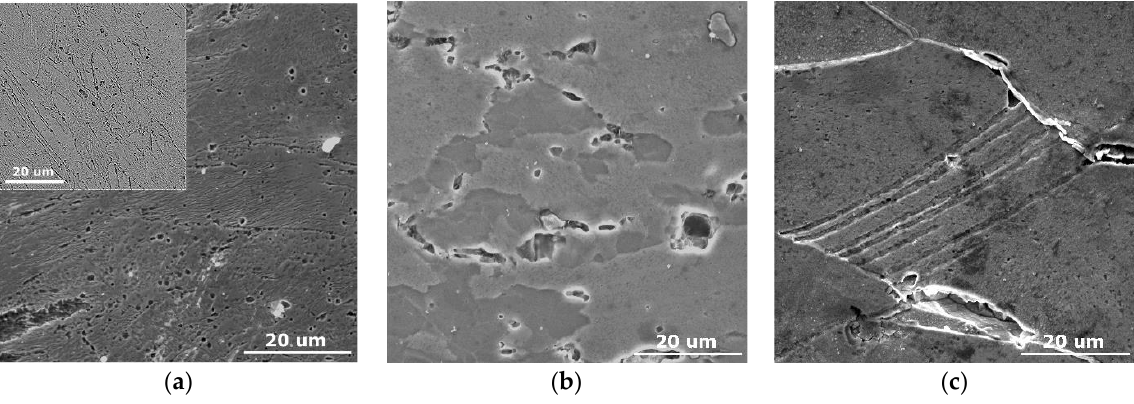
Figure 4. Microstructure in necking zones of ring fragments for ( a ) OFE copper, ( b ) 2017A aluminum alloy, ( c ) Armco iron.